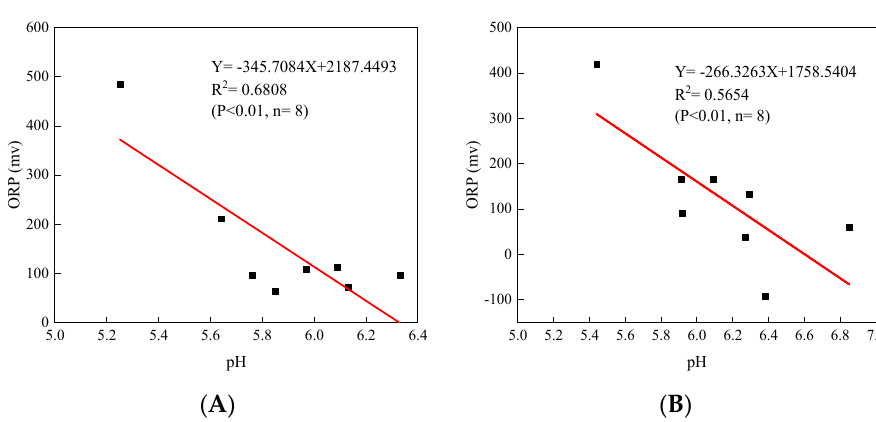
Figure 3. Relationship between soil pH and soil ORP of the ( A ) L T and the ( B ) L S .